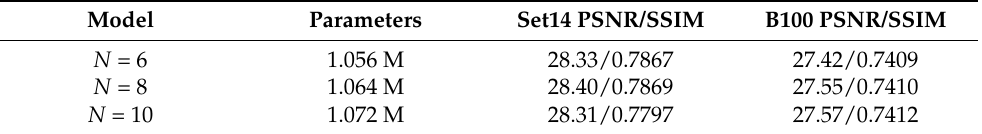
Table 1. Quantitative results of the number of DSCA blocks N . We compare three different models on the Set14 and B100 dataset for 4 × SR.